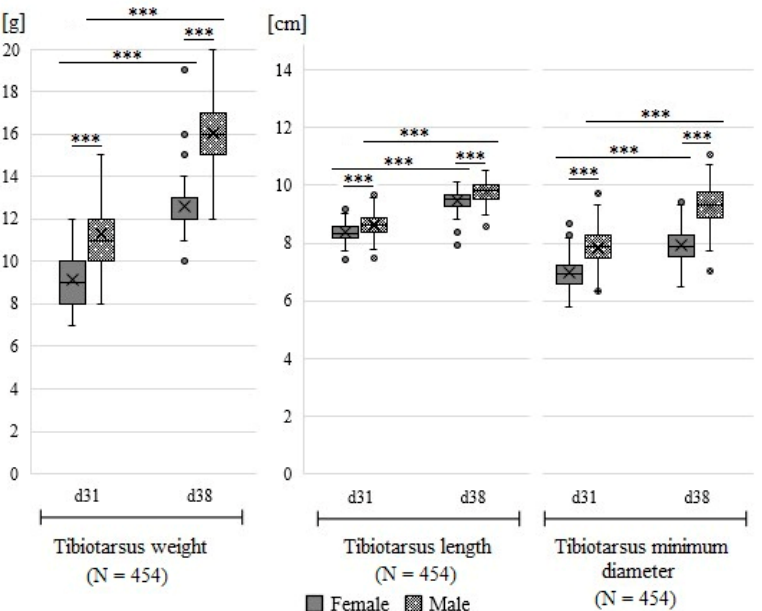
Figure 4. Effect of the interaction between sex (females presented in gray, males presented with patterns) and age at slaughter (day 31, day 38) on tibiotarsus weight, length and minimum diameter. Results are presented as boxplots (data range, median, lower quartile, and upper quartile; outliers are included in the graph as dots); significant differences between sex and age are marked by asterisks: *** p < 0.001 (Tukey–Kramer tests).